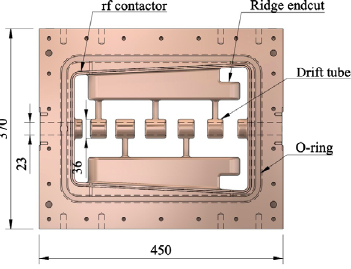
FIG. 3. Side view of the center plate.